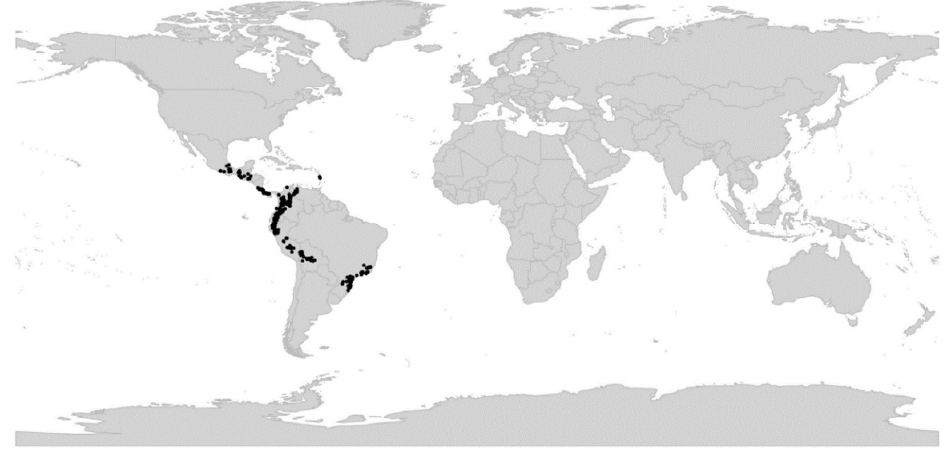
Figure 19. Global distribution of Viola sect. Leptidium